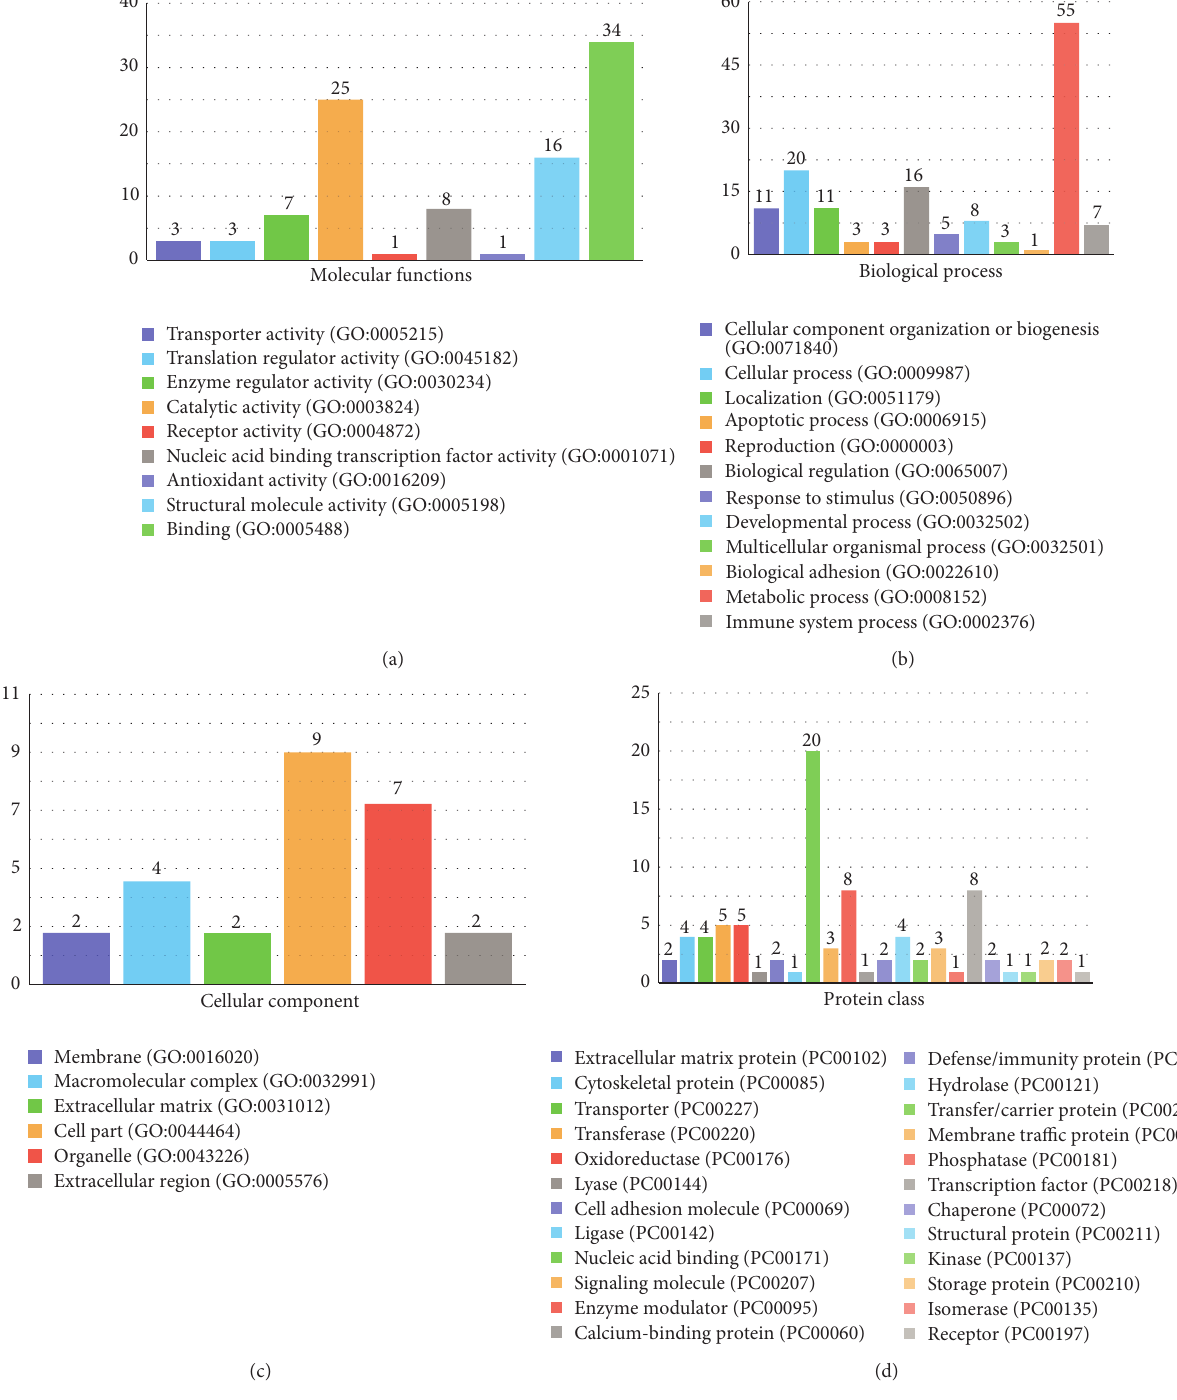
Figure 6: GO terms distribution in the molecular function (a), the biological process (b), the cellular components (c), and the protein class (d) for postnatal